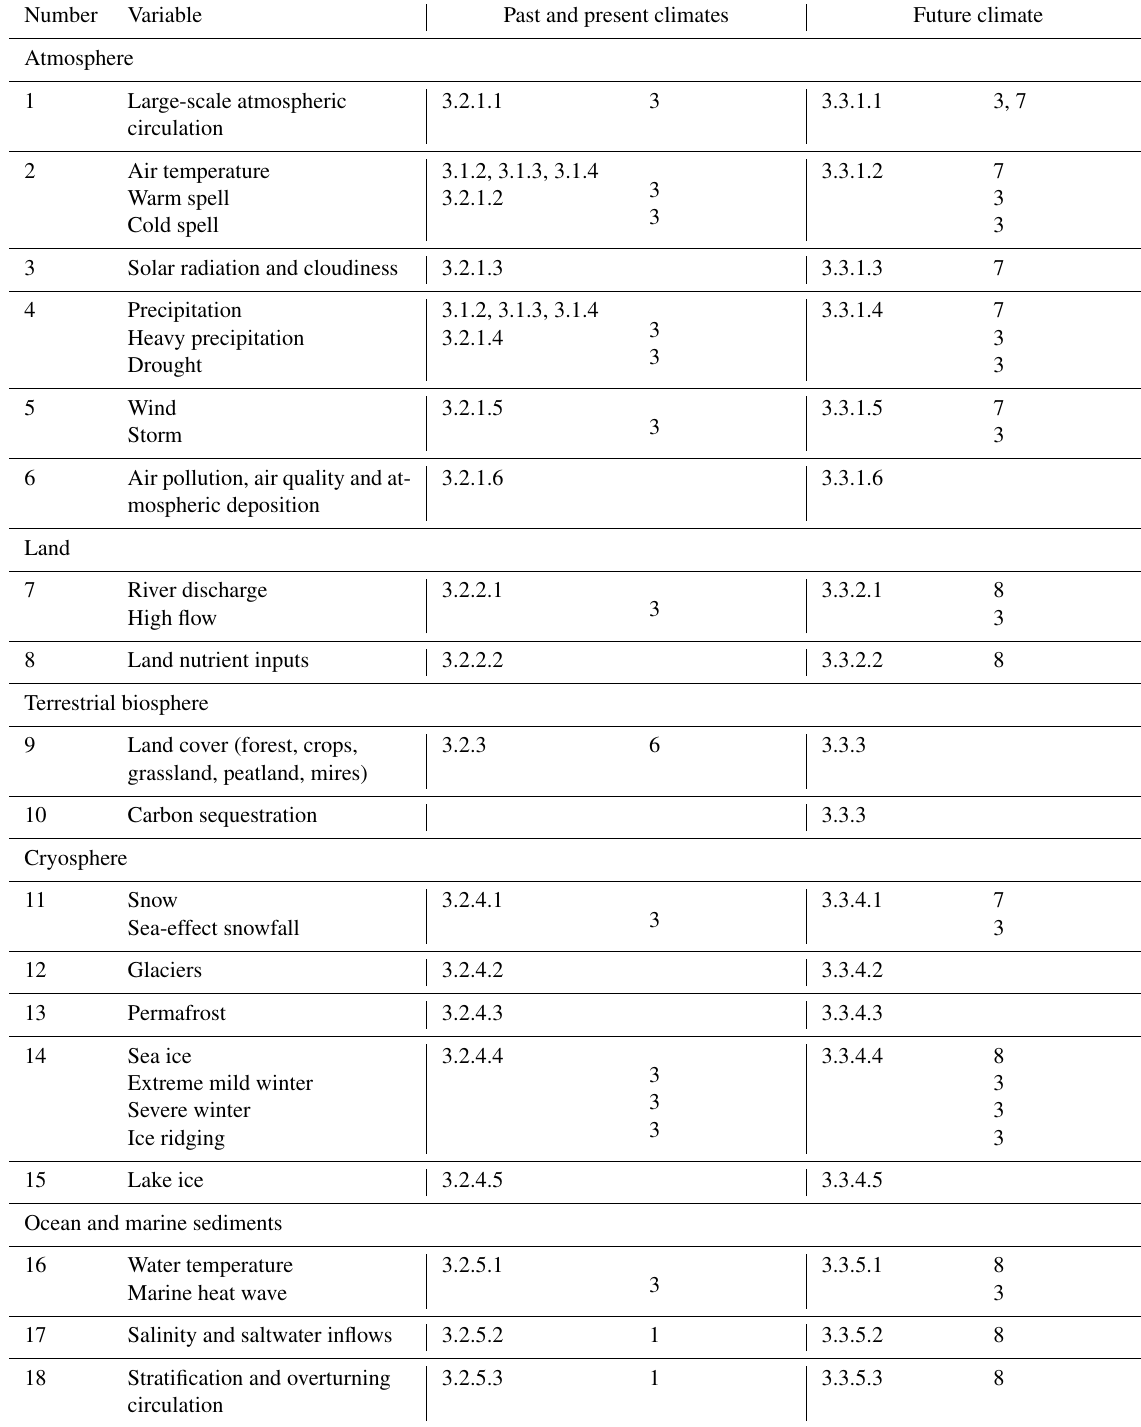
Table 2. Variables of the Meier et al. (2022b) assessment and further references to the BEARs (1: Lehmann et al., 2022; 2: Kuli´nski et al., 2022; 3: Rutgersson et al., 2022; 4: Weisse et al., 2021; 5: Reckermann et al., 2022; 6: Gröger et al., 2021; 7: Christensen et al., 2022; 8: Meier et al., 2022a; 9: Viitasalo and Bonsdorff, 2022). The third column lists the subsection in the study by Meier et al. (2022b) that contains further information. (Source: Meier et al., 2022b; their Table 2 distributed under the terms of the Creative Commons CC-BY 4.0 License, http://creativecommons.org/licenses/by/4.0/, last access: 4 February